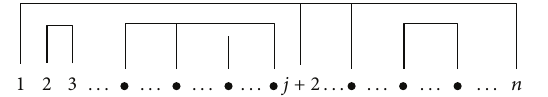
Figure 1: The main structure of noncrossing partitions of {1,2,3,...,𝑛} with the first and 𝑗 + 2 element in the same